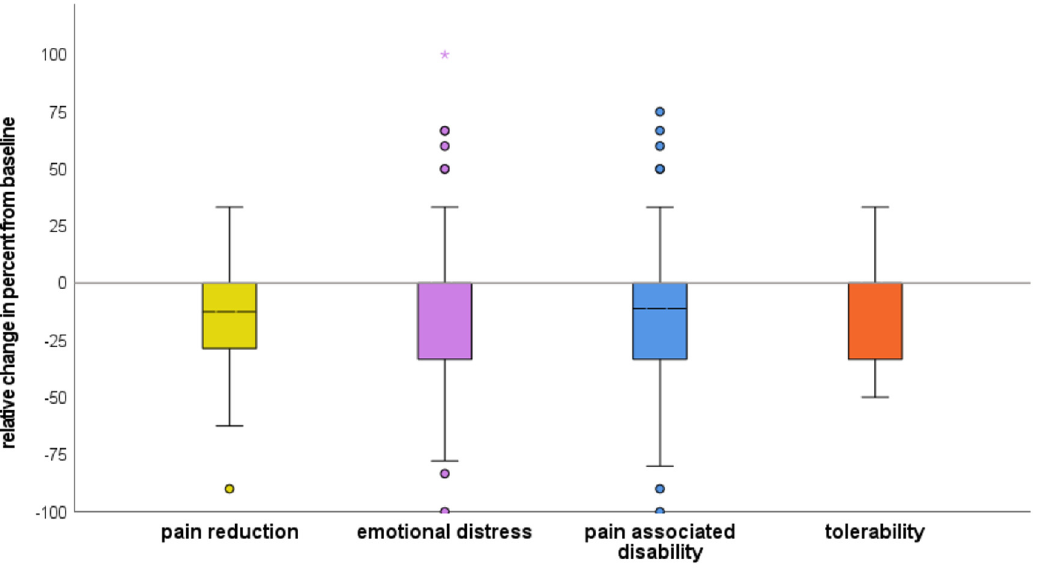
Figure 2. PROM trajectories during treatment with cannabinoids. Colored dots represent data points (outliers) that have 1.5* to 3.0* interquartile range to the 1st or 3rd quartile. Stars indicate data points (outliers) that have a distance greater than 3.0* interquartile range. Table 3. Multivariate logistic regression analysis of the association between at least a 30% reduction in mean pain intensity and cofactors under